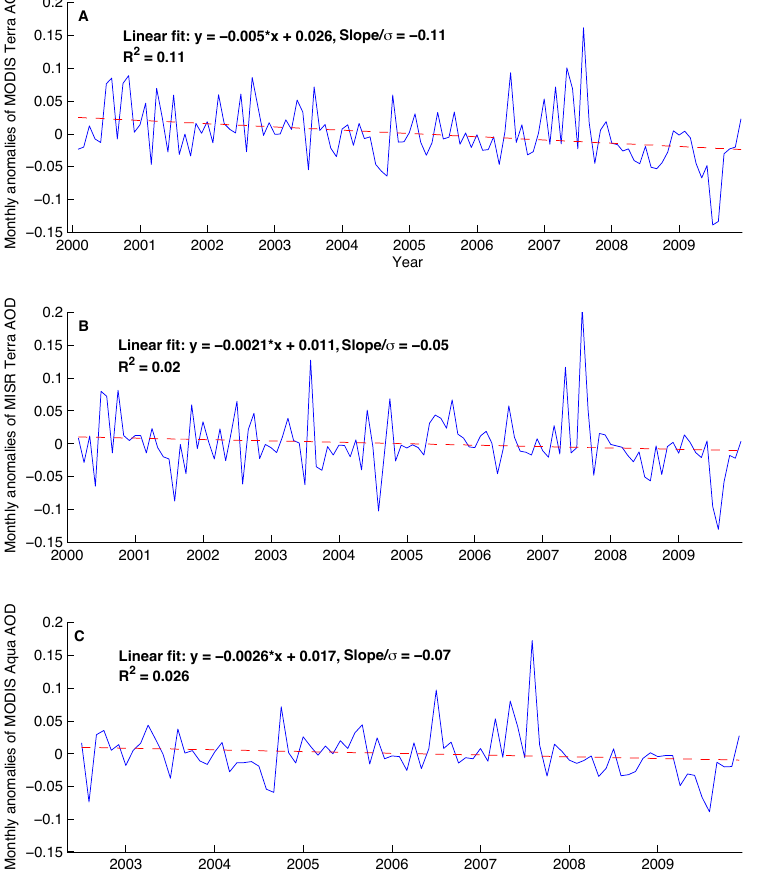
Fig. 9a. (A–C) Time series of monthly anomalies for MODIS Terra AOD, MISR Terra AOD, and MODIS Aqua AOD. Dashed red lines denote linear regression trend lines (see Table 1). Linear regression equations, linear fit statistics and normalized slopes = slope/standard deviation ( σ ) are